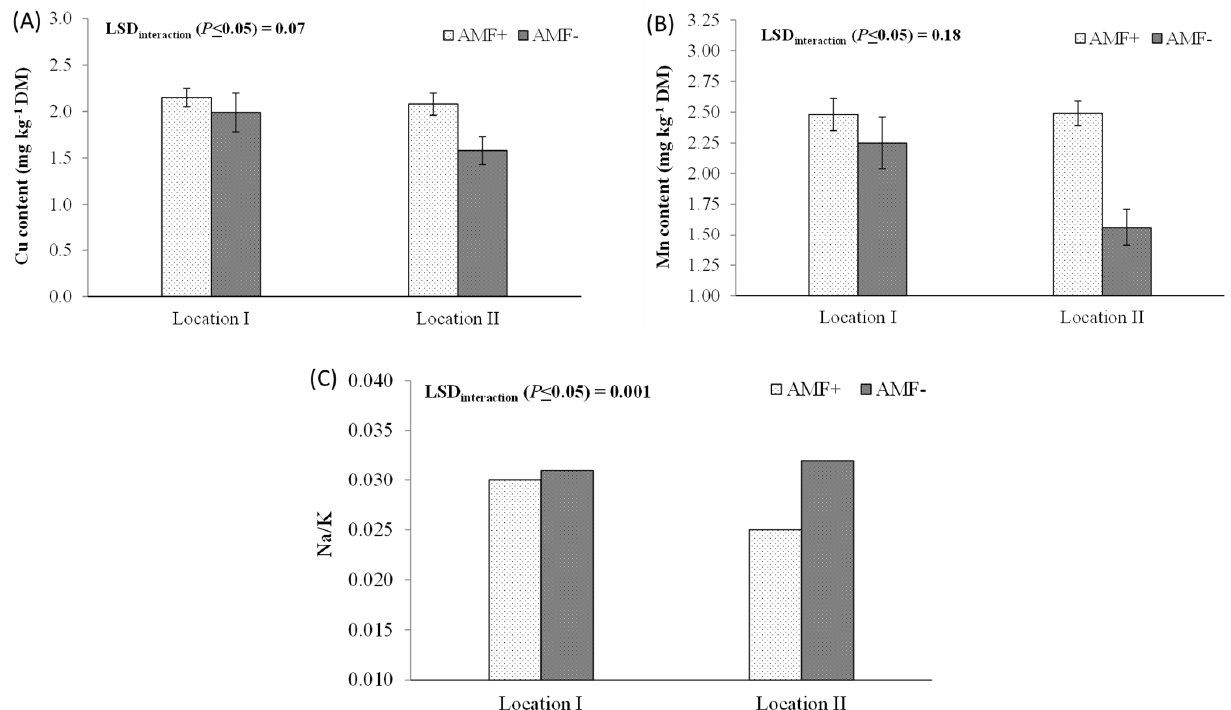
Figure 3. Effect of “soil mycorrhization × location” interaction on the tuber levels of Cu ( A ), Mn ( B ), and Na/K ( C ). Data are presented as mean ± standard deviation. The ± standard deviation of ratio Na/K is ≤ 0.001. AMF+: mycorrhizal inoculated plots; AMF ‐ : non ‐ mycorrhizal inoculated plots.